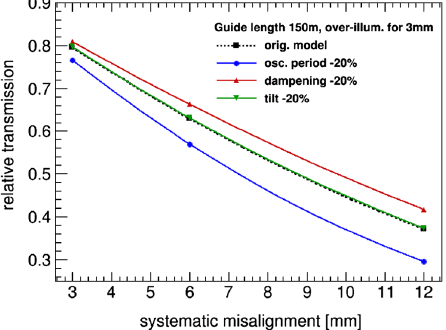
5. Estimation of systematic uncertainty of the relative transmission with overillumination, assuming modifications to Eq. (1). Relative transmission is plotted against amplitude of systematic misalignment, assuming a 3 mm overillumination, with the original function, a 20% change variation in the period of the damped cosine, the same 20% change in the damping factor, and also in the